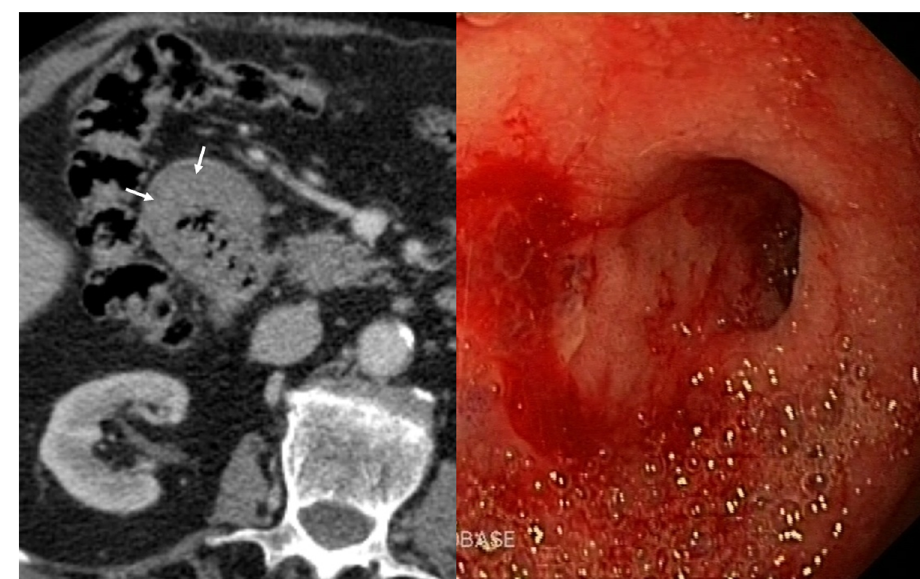
Fig. 11 An 88-year-old man who was treated with oral anticoagulants for ischemic heart disease, presented with coffee ground vomitus. Axial contrast- enhanced CT shows homogeneous concentric thickening (arrows) of the duodenal wall at the level of the bulb. Upper endoscopy detected an ulcer in the duodenal bulb with active oozing haemorrhage which was sclerosed with